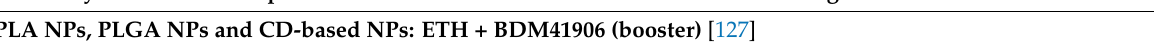
Table 2. Cont. Physicochemical Properties Biological